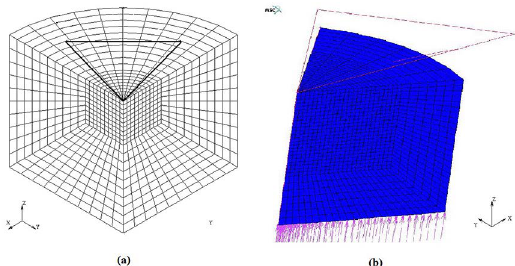
Figure 2. Illustrations of numerical mesh with isoparametric brick elements (a) for the Vickers model with 1 4 symmetry; and (b) for the Berkovich model with 1 6 symmetry.